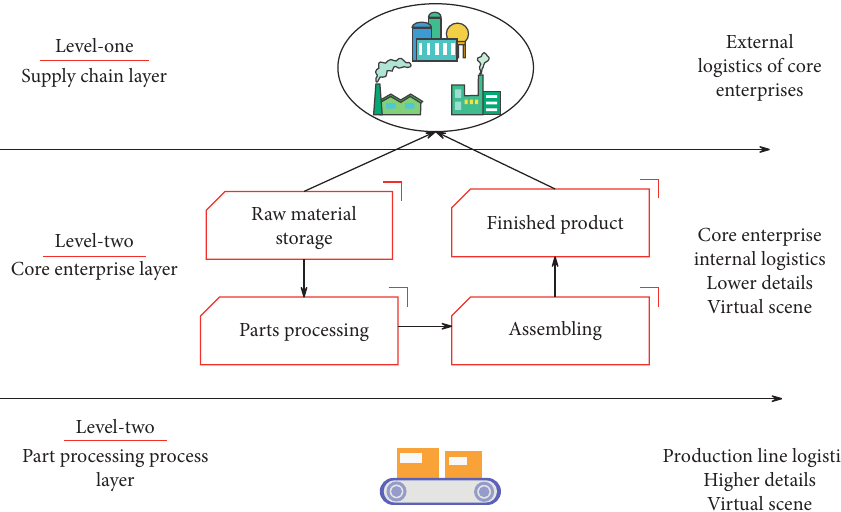
Figure 5: Visualization levels of the supply chain.